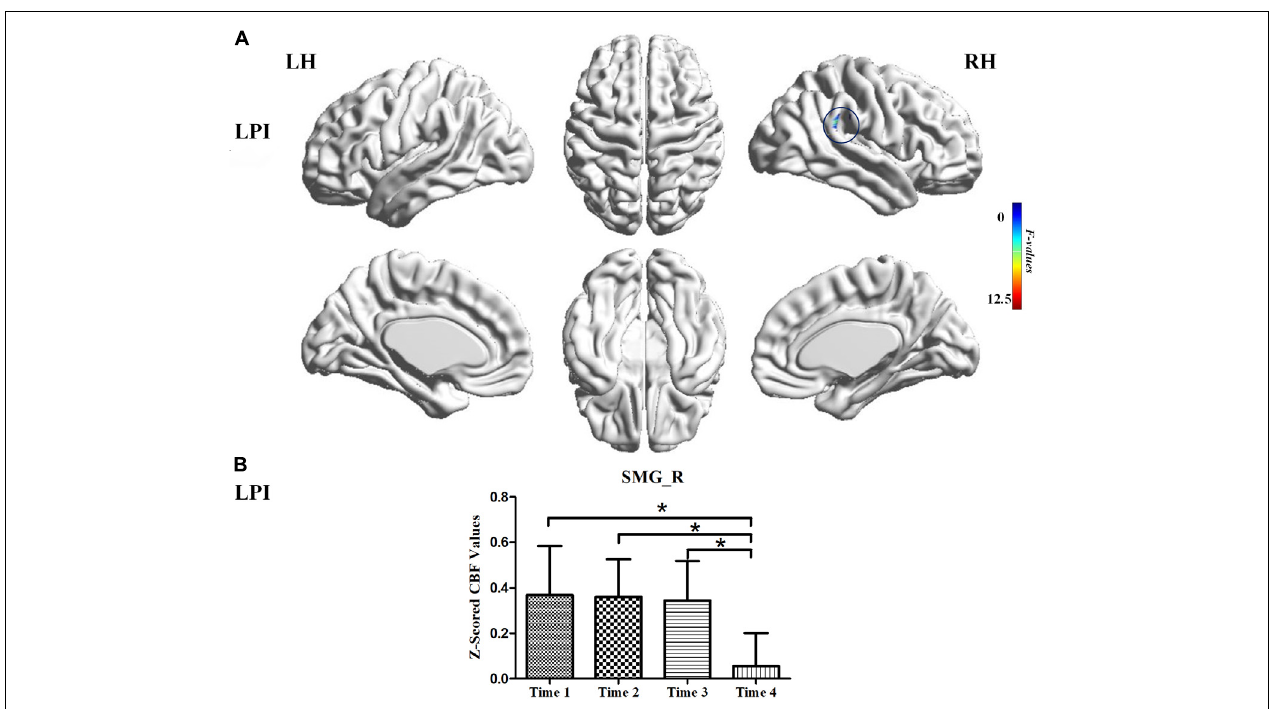
FIGURE 3 | CBF differences among different time-subgroups in the LPI group. (A) One-way repeated-measure ANOVA showed brain regions with CBF differences among four follow-up subgroups in the SMG_R. The color bar indicated the F scores. (B) Bar plots showed the z -scored CBF values of the SMG_R at four different time-subgroups and the change trend from the baseline stage to 6 months after infarction. SMG_R, right supramarginal gyrus; Time 1, Time 2, Time 3, and Time 4, different time subgroups from 1 week to 6 months after infarction; LH, left hemisphere; RH, right hemisphere; LPI, left pontine infarction. * P <